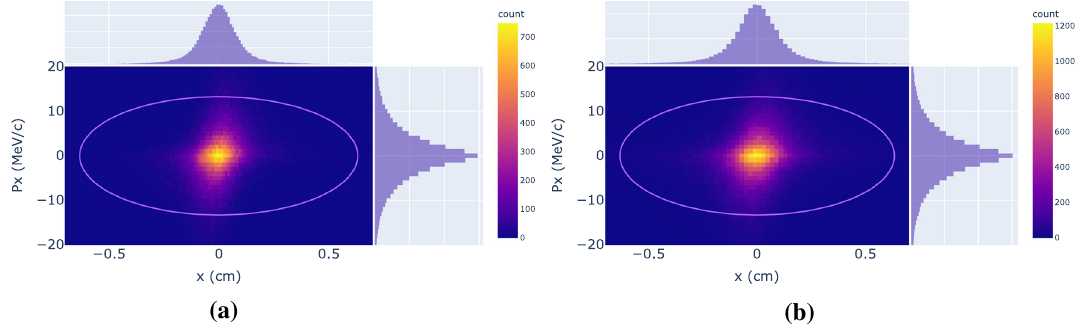
Fig. 11 Positron transverse phase space at the target exit and the acceptance boundary for the conventional scheme ( a ) and hybrid scheme ( b ). About 80% of the generated positrons are within the theoretical transverse acceptance in x–P x plane for both